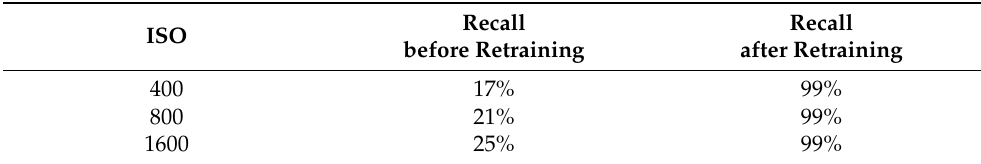
Table 4. Recall for one class: Person.